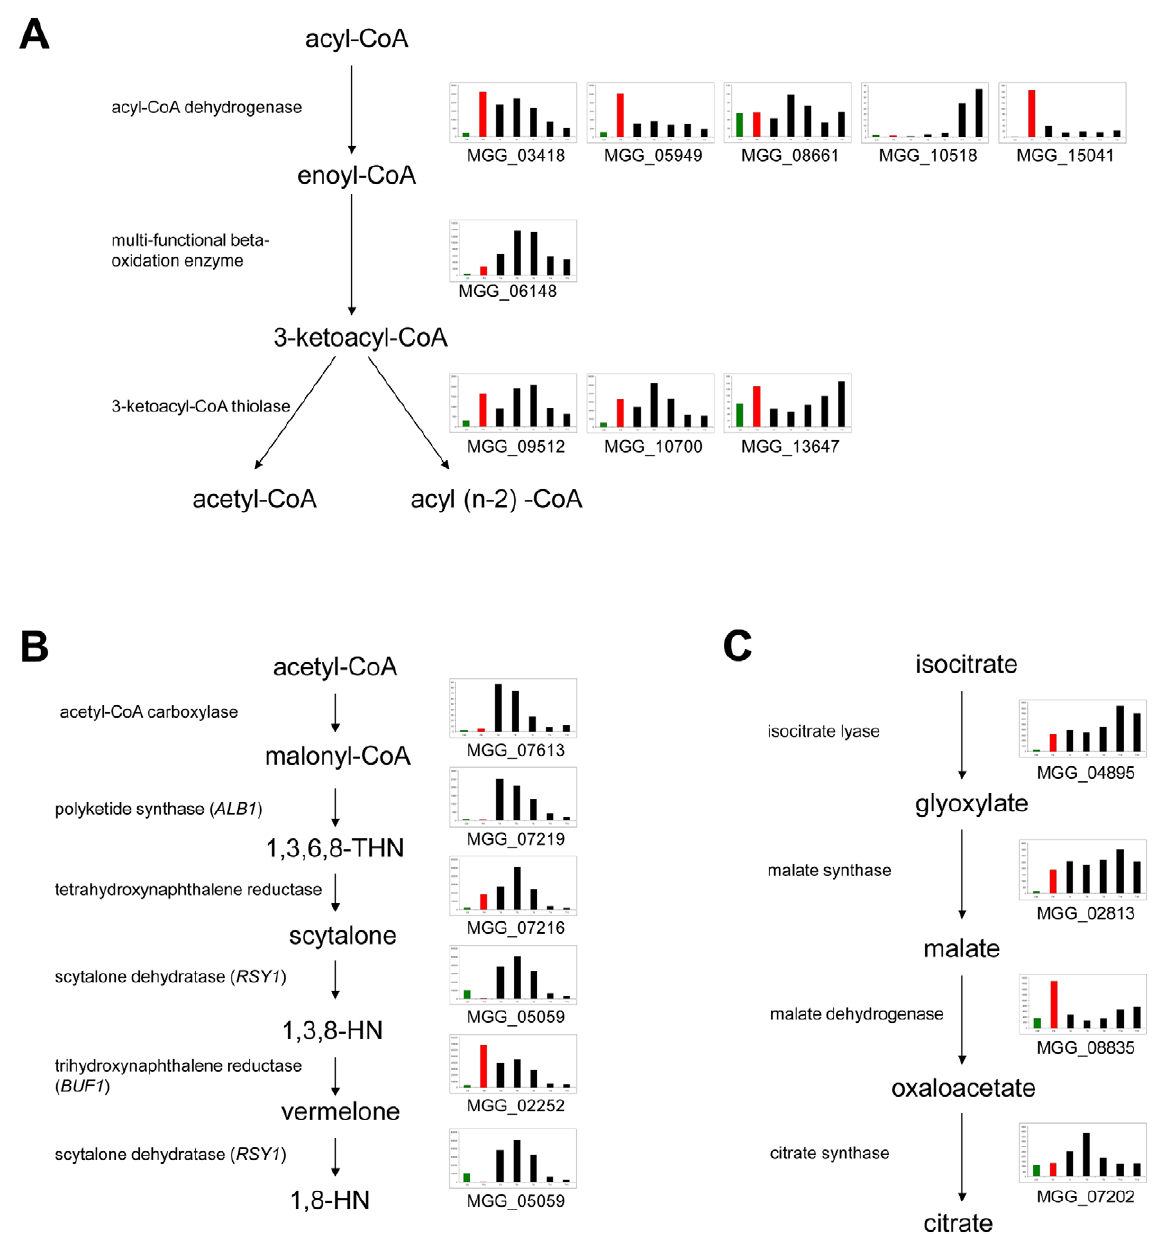
Figure 4. Expression of genes encoding enzymes from three metabolic pathways that affect the pool of acetyl-CoA. A . The b - oxidation pathway, B . melanin biosynthesis, C . the glyoxylate shunt. For each enzyme, bar graphs show abundance of transcripts encoding this gene in: Guy11 mycelium grown in complete medium (green bar), D pmk1 mutant conidia left to germinate for 4 h (red bar), Guy11 time course of appresorium development (4 h, 6 h, 8 h, 14 h, 16 h – black bars left to